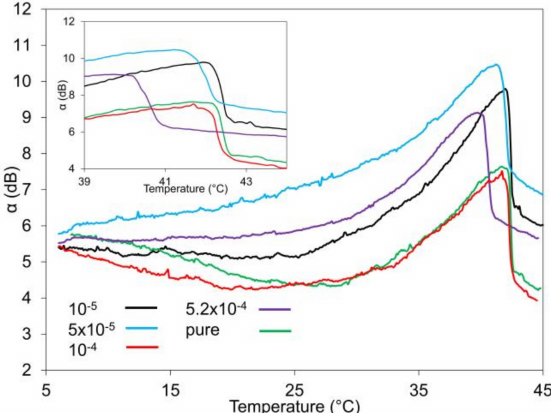
Figure 5. Temperature dependence of SAW attenuation of 6CHBT doped with nanorods of di ff erent